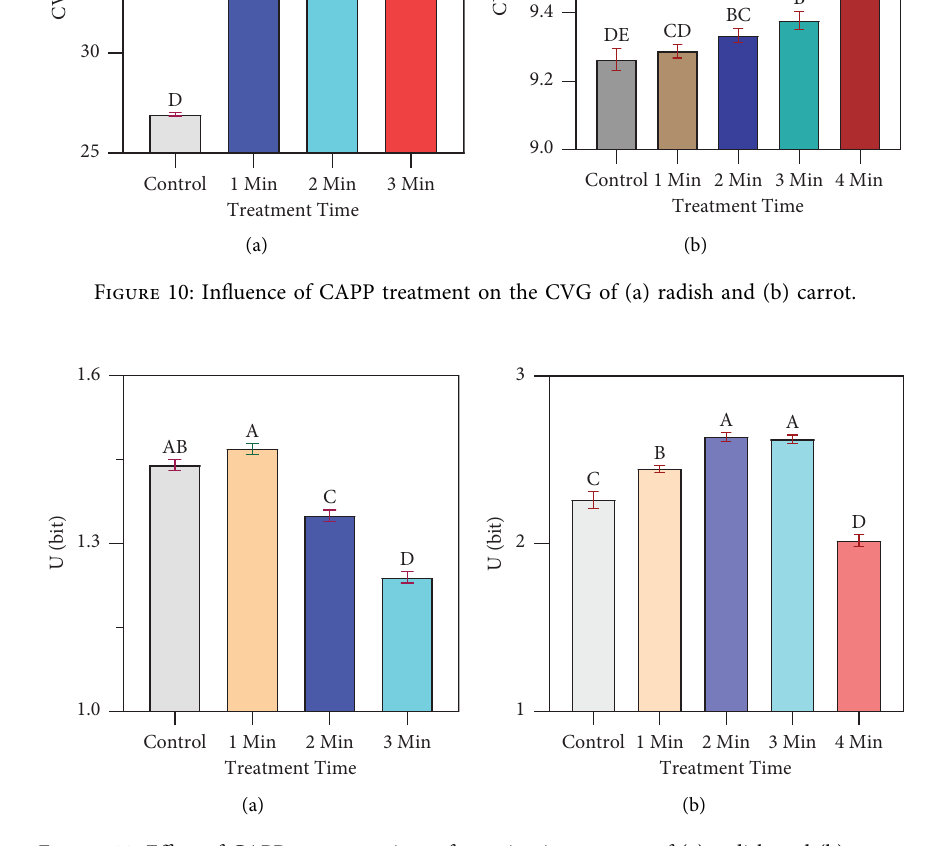
Figure 11: Efect of CAPP on uncertainty of germination process of (a) radish and (b) carrot.